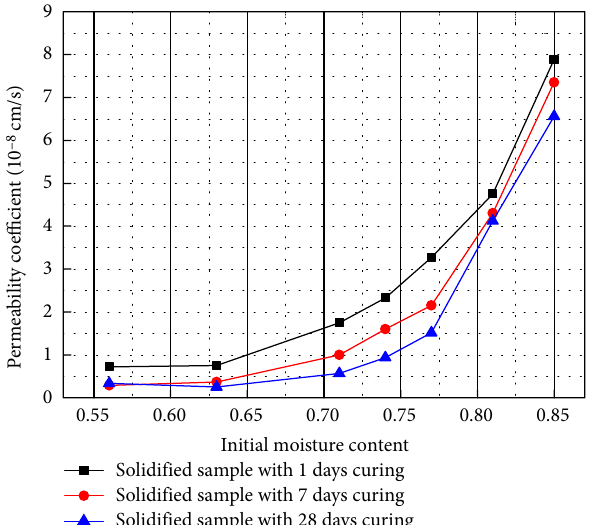
Figure 5: Permeability coefficient of solidified sludge body after drying-saturated.